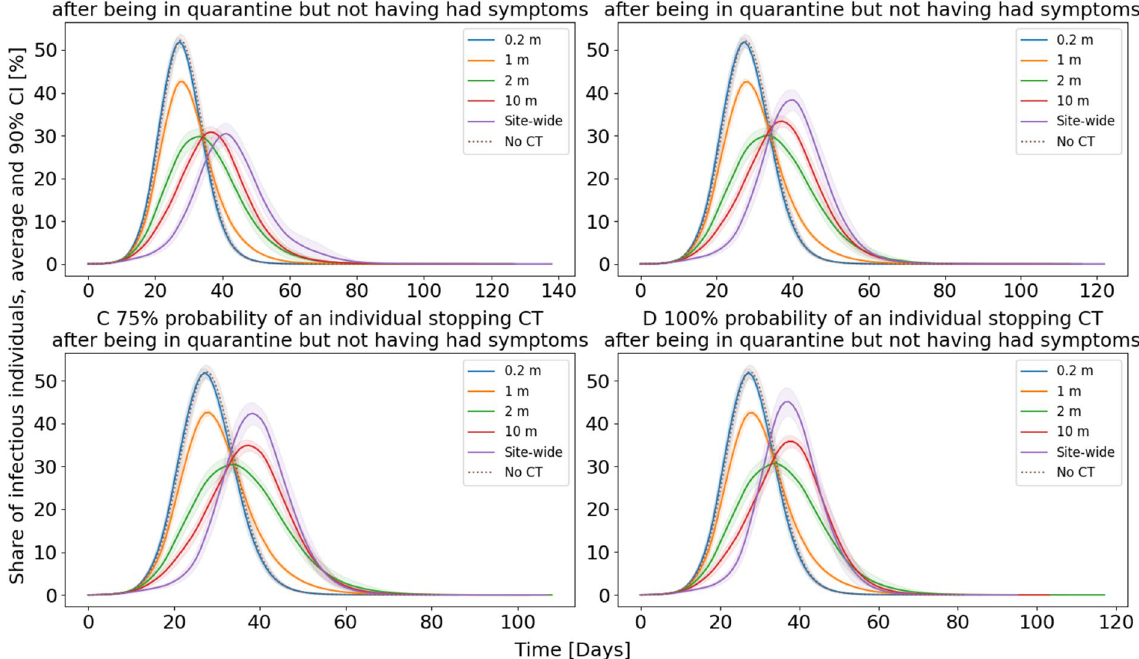
Figure 3. Usage stop of CT after being in a false positive quarantine. For each curve, the mean from 30 simulations, and the 90% confidence intervals are plotted. Thereby, the initial adoption rate of CT is 60%. The probability of stopping CT after a false positive quarantine varies in the